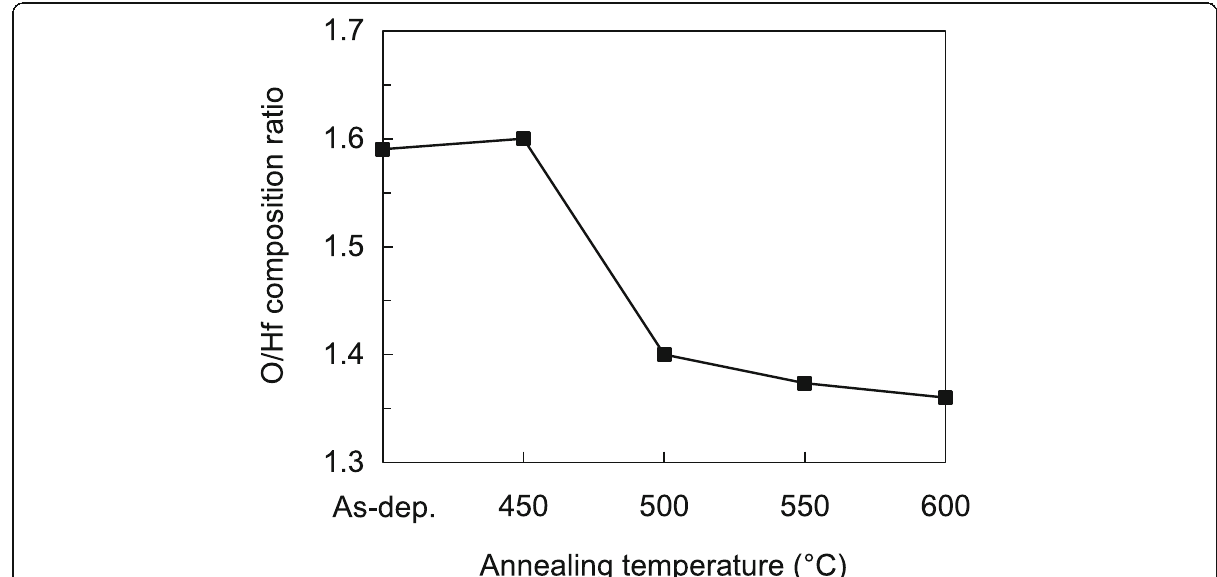
Fig. 3 Atomic ratio of oxygen to hafnium for HfO 2 thin films annealed at different